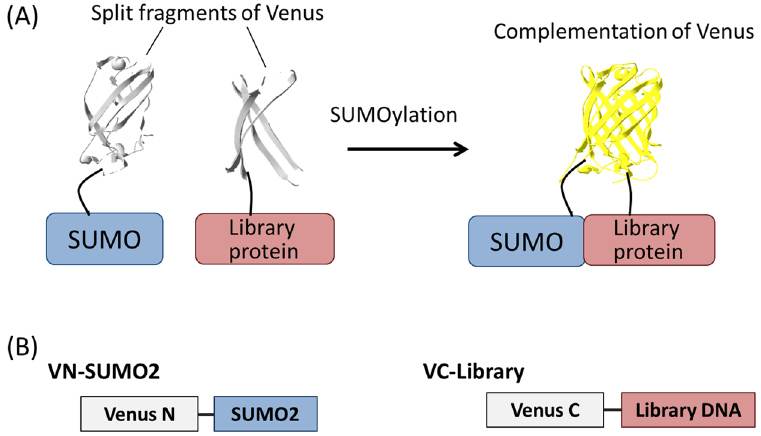
Figure 1. The probes for detecting SUMOylation in living cells. ( A ) Schematic for detecting SUMOylation under live-cell conditions using the reconstitution of split fluorescent protein fragments. ( B ) Schematic structures of VN-SUMO2 and VC-library probes. Venus N: N-terminal fragment (amino acids 1 to 158) of Venus. Venus C: C-terminal fragment (amino acids 159 to 240) of Venus